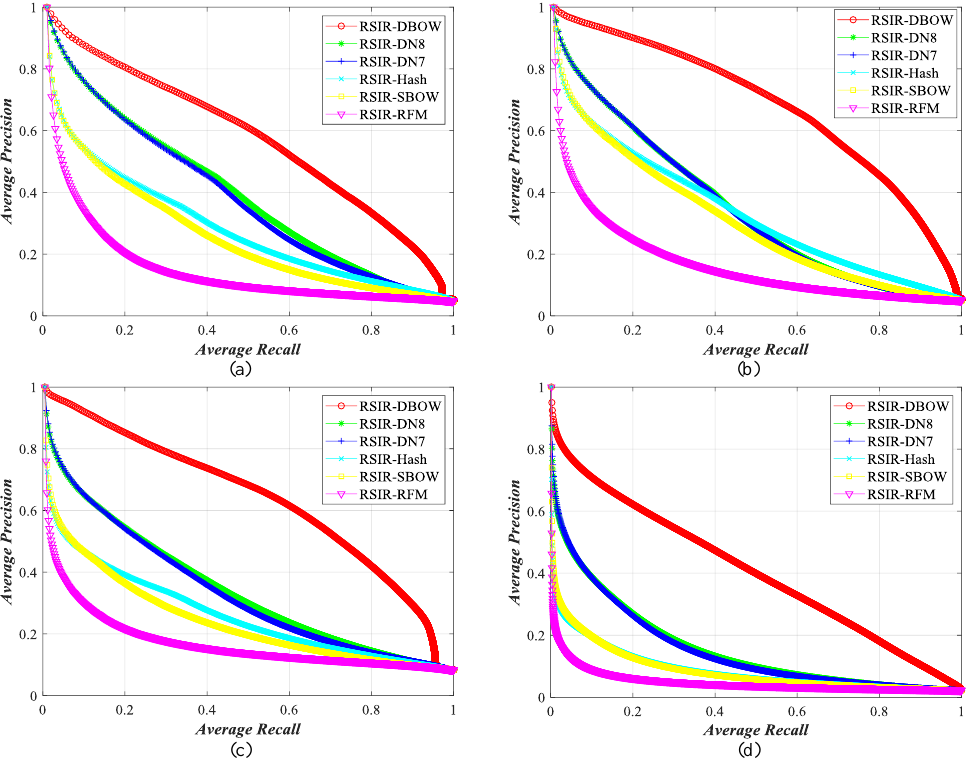
Figure 18. Recall–precision curve of different RSIR methods on four RS image sets. ( a ) the results on ImgDB1; ( b ) the results on ImgDB2; ( c ) the results on ImgDB3; ( d ) the results on